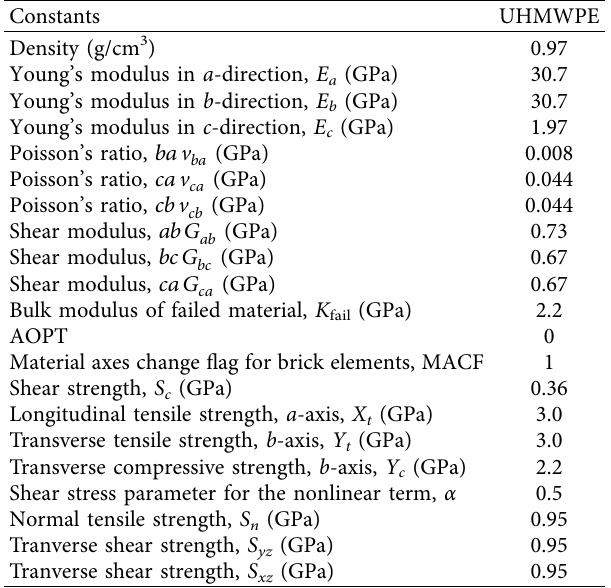
Table 3: ∗ MAT_COMPOSITE_DAMAGE [23] constants for